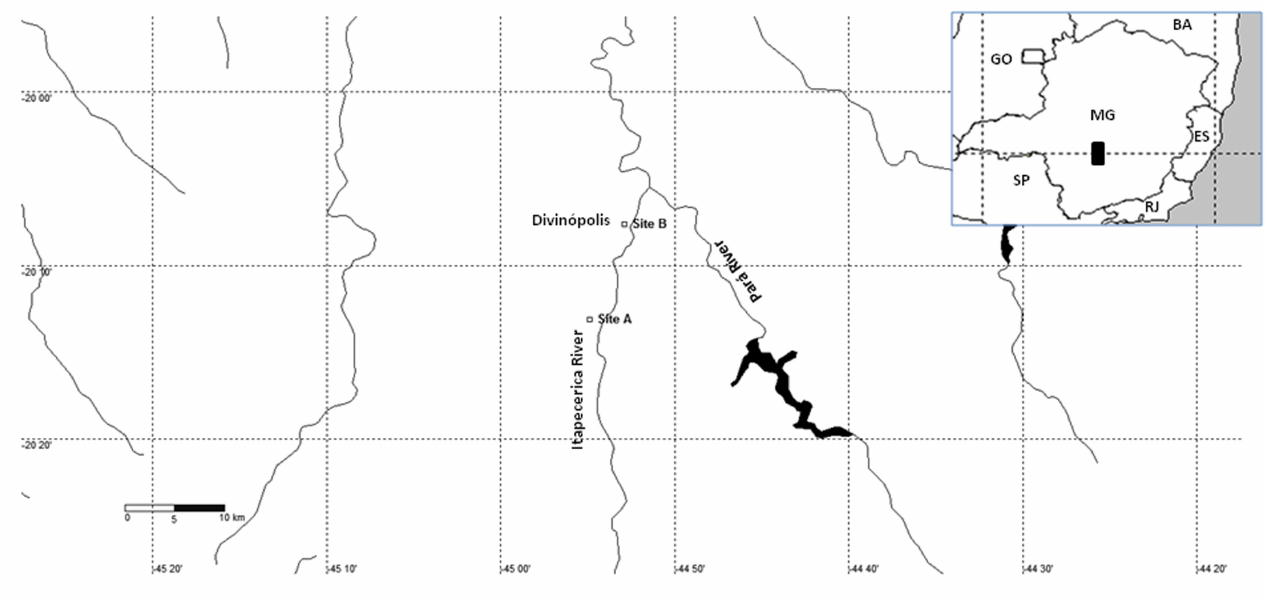
Location of sampling sites in the Itapecerica River, São Francisco River basin: site A upstream (20°13’09”S-44°54’51”O) and site B in the center of Divinópolis (20°07’80” S-44°52’83”